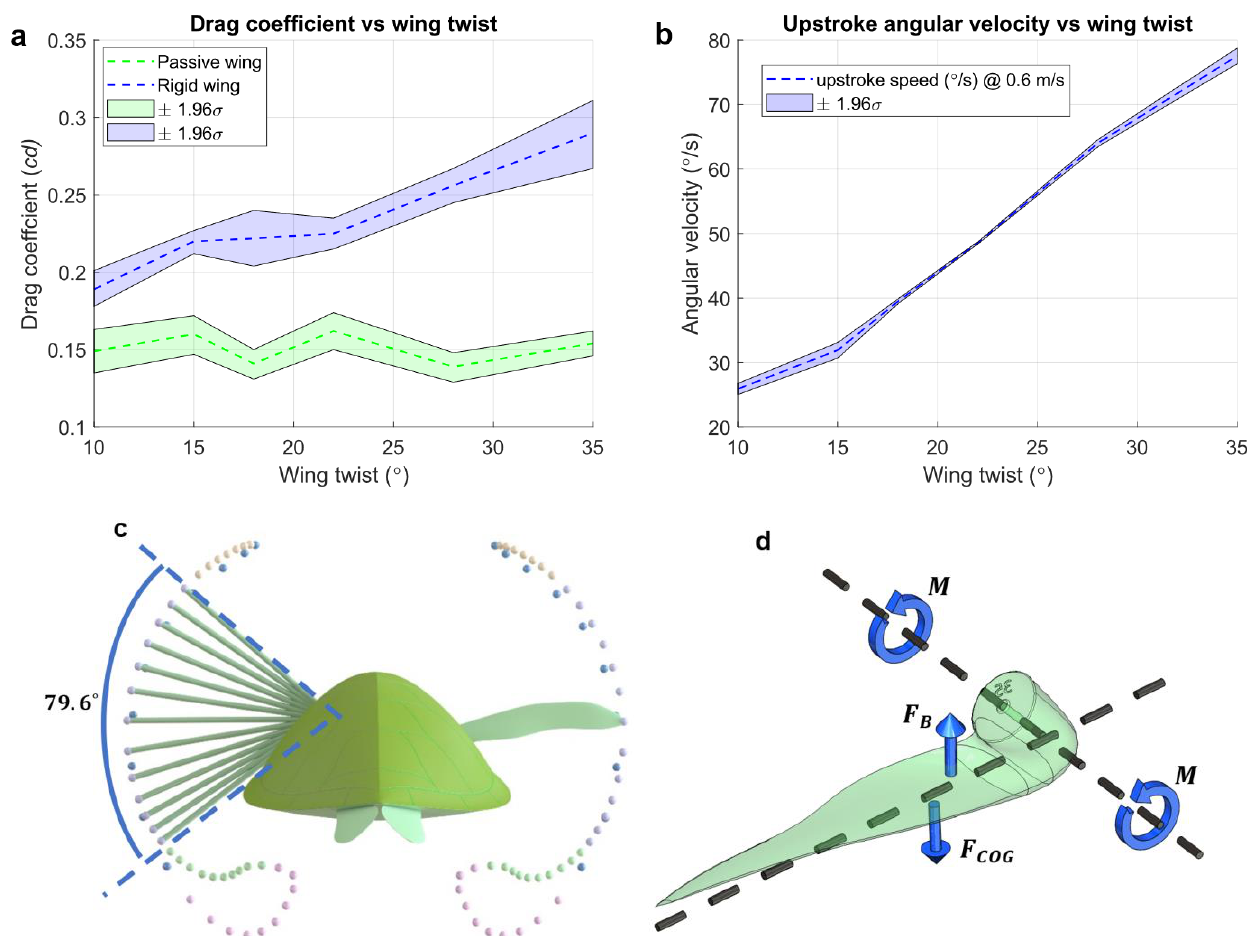
Figure 7. C.F.D. post-processing results of flow field velocity for a rigid wing of flex 35°. ( a ) Rigid wing generating the wingtip vortex. The image on the left shows streamlines starting at the turtle ’ s wing. The image on the right shows the vortex core via a transverse plane. ( b ) Longitudinal section plane through turtle wing showing flow separation due to adverse pressure gradients observed on rigid wings.